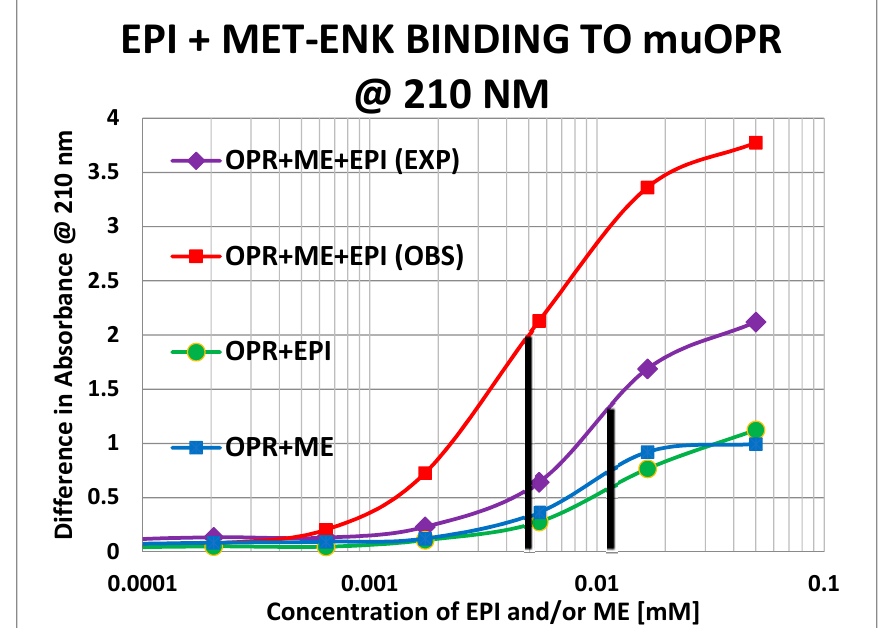
Figure 15. Mu opioid receptor (OPR) binding curves with methionine-enkephalin (ME), epinephrine (EPI) and their combination (ME + EPI) at 210 nm. The choice of 210 nm is explained in Figure 10. The experimentally observed binding curve (OPR + ME + EPI (OBS)) is compared with the theoretically predicted binding calculated from individual binding of ME to OPR and EPI to OPR (OPR + ME + EPI (EXP)). There is a half-log unit shift to the left (black vertical lines) in the observed binding as compared with the predicted binding (12 μ M versus 5 μ M).